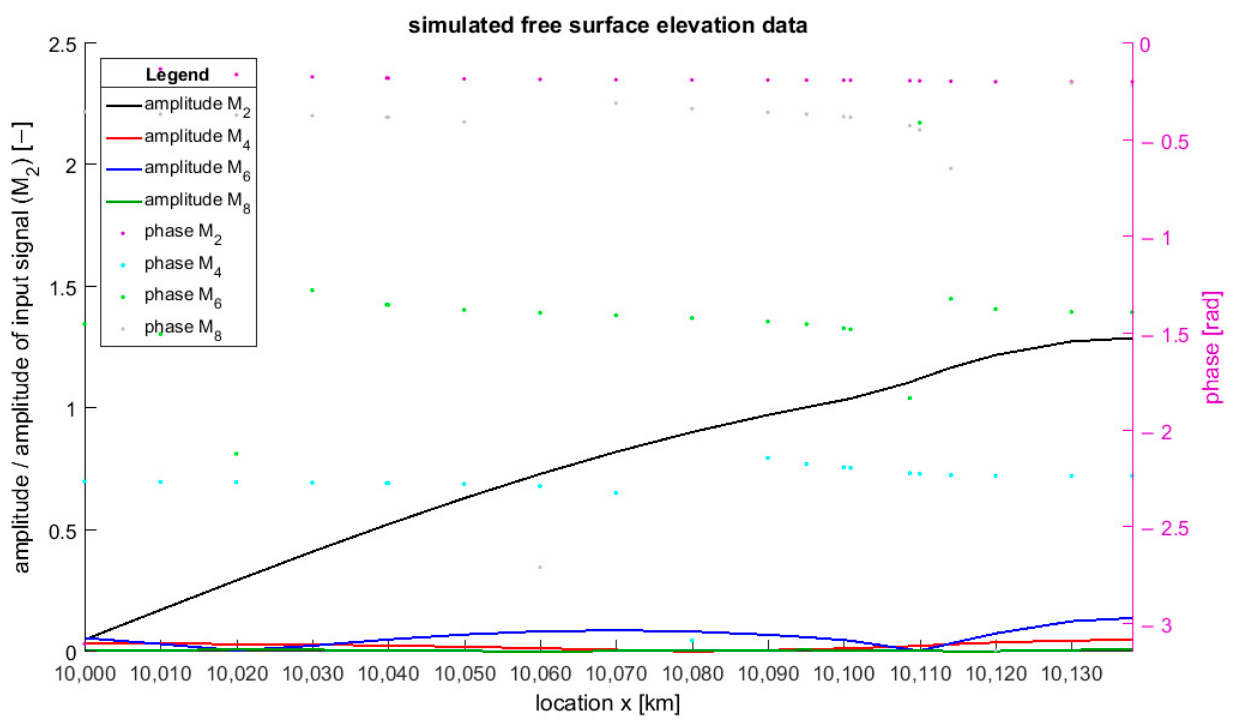
Figure 7. Visualization of the harmonic analysis results (M 2 , M 4 , M 6 , M 8 ) of the simulation data along the length sections section from x = 10,000 km to 10,139 km from a model with a bathymetric change (at x = 10,100 km), constant model widths and a total reflector (x = 10,138 km).